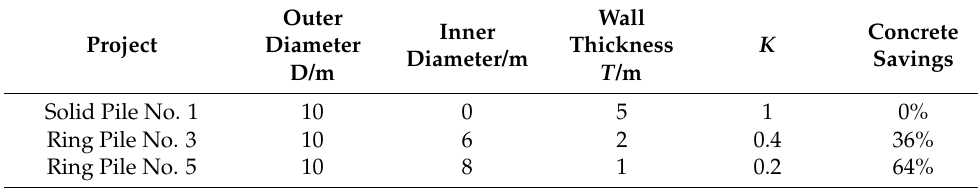
Table 8. Input parameters for the numerical